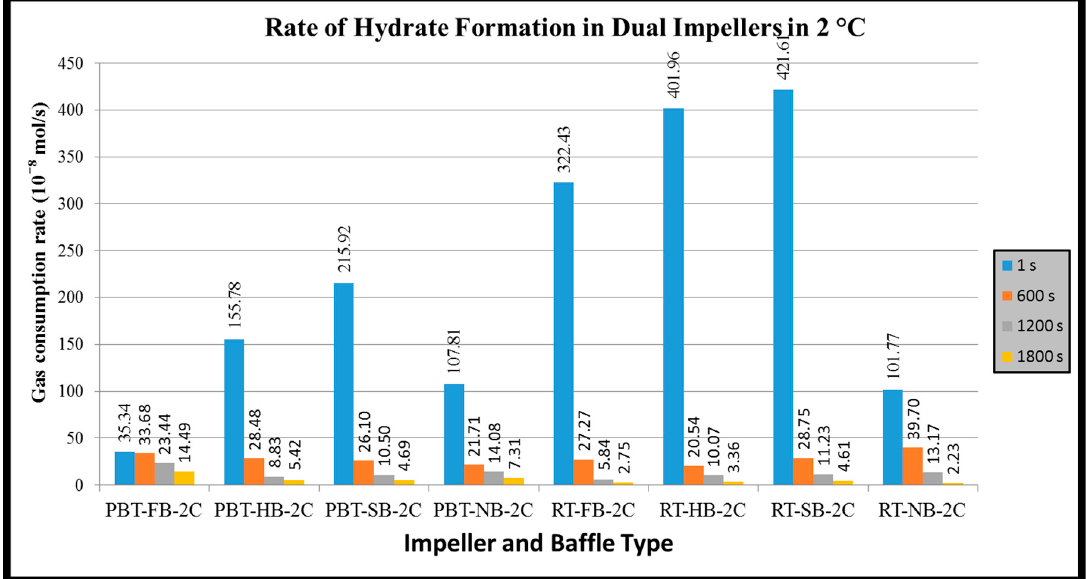
Figure 10. Rate of hydrate formation of mixture gas with dual impeller (experimental temperature 2 °C).